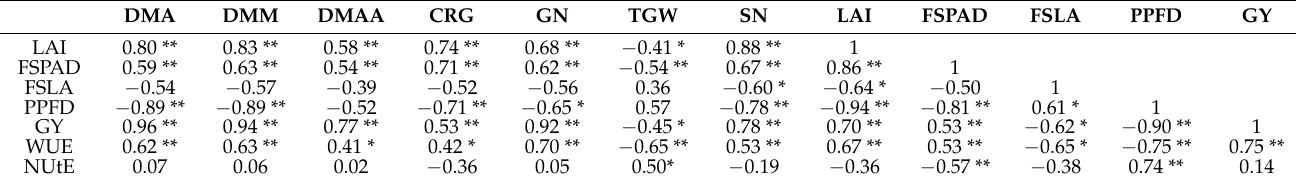
24 DAA. Table 7. Pearson correlation coefficients among GY, WUE, NUtE, canopy characteristics traits agronomical and physiologi- cal